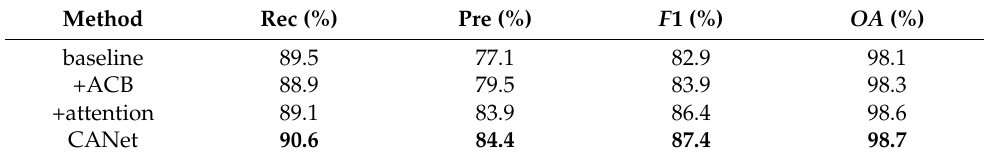
Table 6. LEVIR-CD dataset ablation experiment (the best performance is emphasized in bold). Method